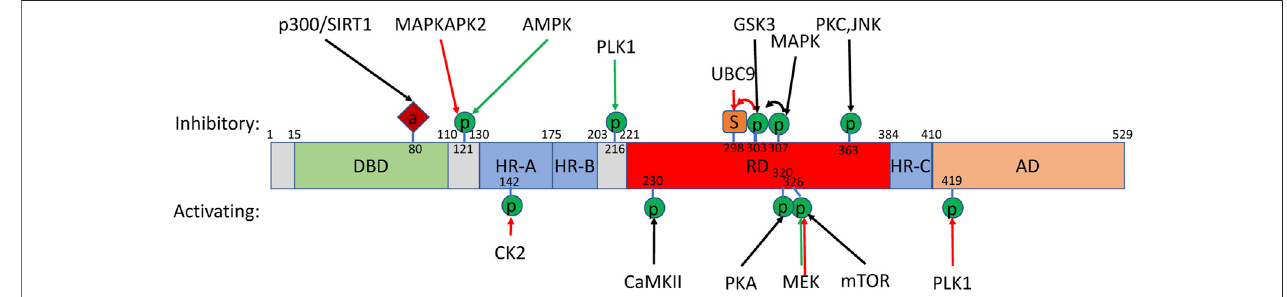
FIGURE 2 | HSF1 post-translational modi fi cations. Schematic of mammalian HSF1 secondary structure with post-translational modi fi cations with known regulators and overall effect on activity. Additional modi fi cations without known regulators are listed in Table 1 . Additional regulators where a speci fi c post-translational modi fi cation has not been identi fi ed have been omitted. “ DBD ” indicates the helix-turn-helix loop DNA-binding domain. “ HR-A/B ” and “ HR-C ″ identify two regions of leucine zippers. “ RD ” indicates the regulatory domain. “ TAD ” indicates the transcriptional transactivation domain. Modi fi cations in response to heat (red arrows) or metabolic/mitogenic signals (green) are shown. Amino acid numbers are indicated. “ P ” indicates phosphorylation. “ S ” indicates sumoylation. “ A ” indicates